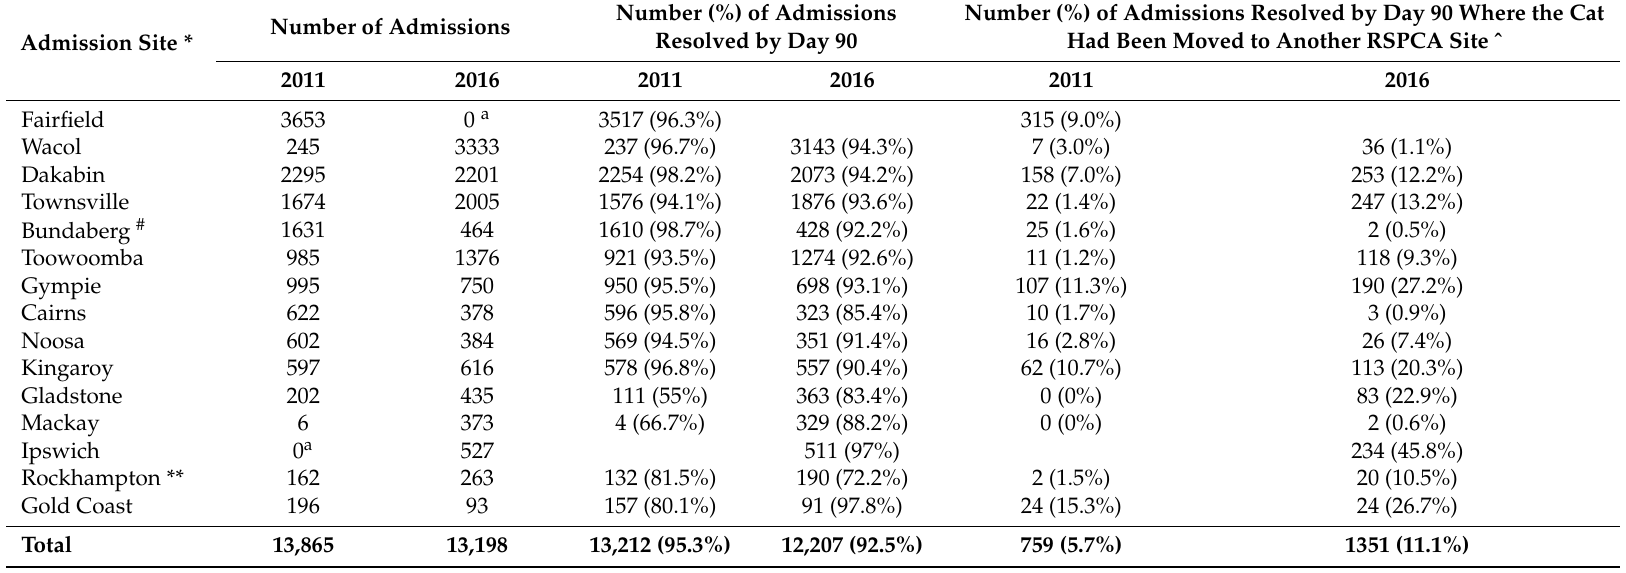
Table A2. Numbers of admissions to RSPCA shelters and adoption centers for the years 2011 and 2016, numbers of admission resolved by the 90th day of their admission (‘day 90’; where day 1 was the day the cat was admitted), and numbers of admissions in which the cat was moved to another RSPCA site. Number (%) of Admissions Resolved by Day 90 Where the Cat Had Been Moved to Another RSPCA Site